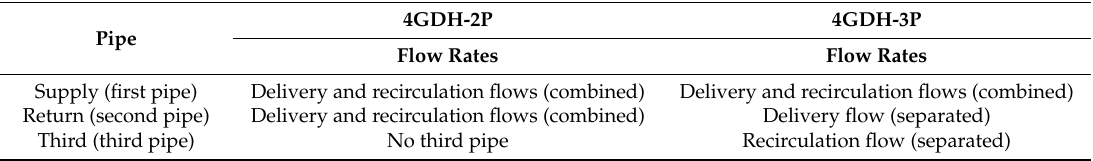
Table 1. Definitions of terminology used for the two versions of fourth generation district heating (4GDH).